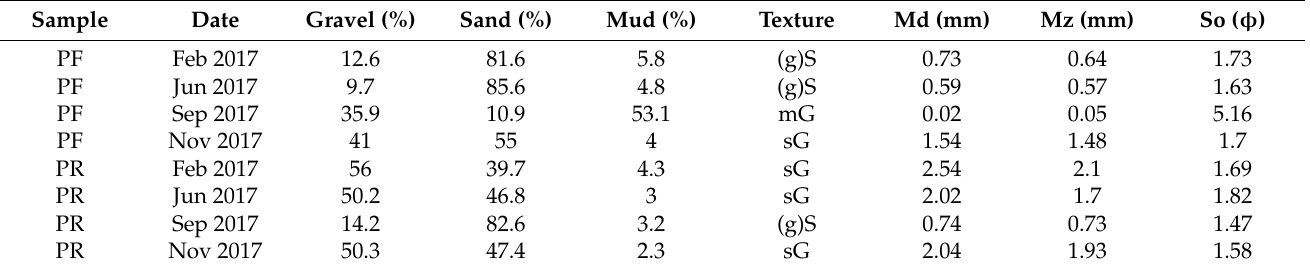
Table 3. Summarized grain size data for Pelješac fish farm (PF) and Pelješac reference site (PR).